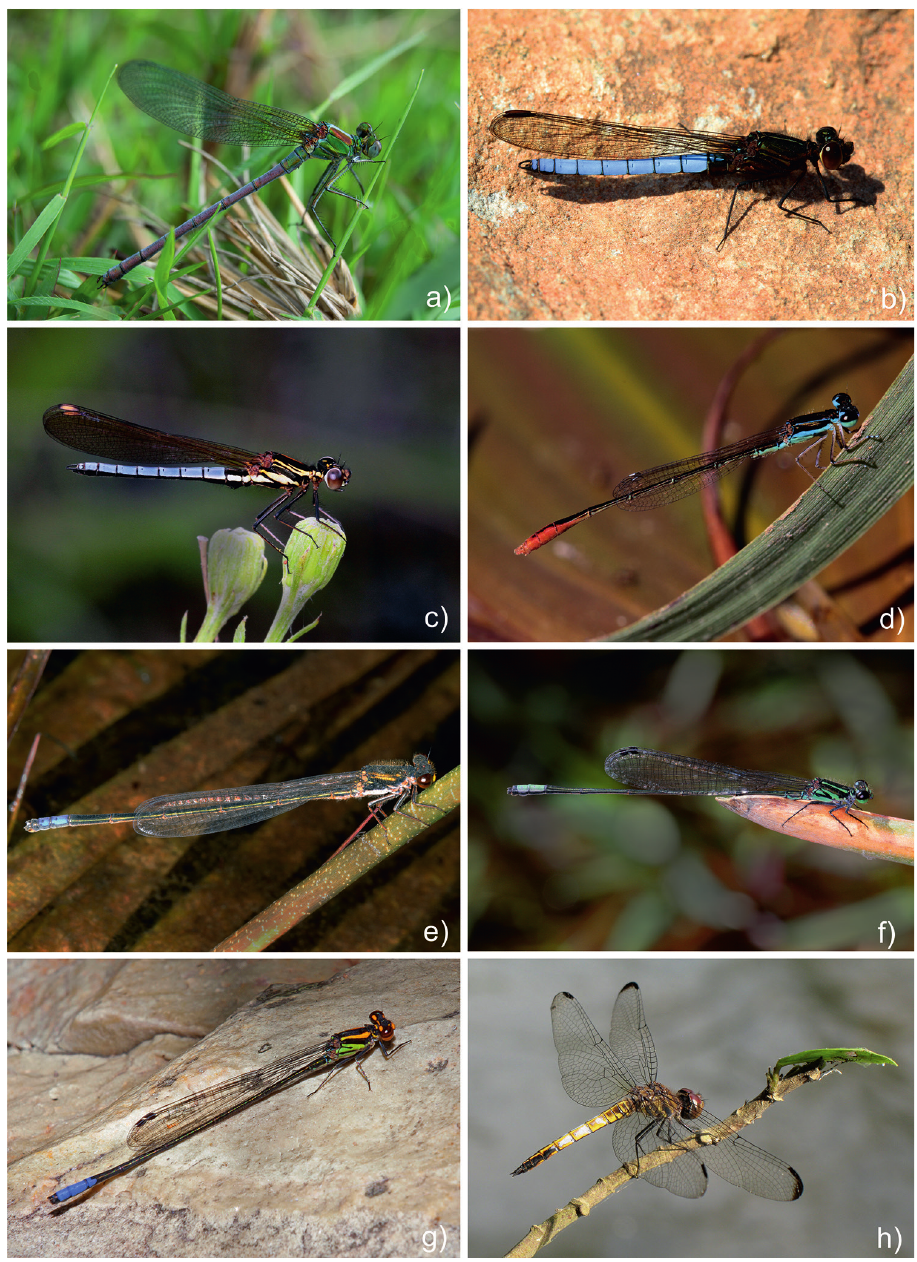
Figure 5. Photographs of some of Angola’s (near) endemic dragonflies and damselflies. a Angola Spar- klewing ( Umma femina ) b Highland Blue Jewel ( Platycypha bamptoni ) c Angola Blue Jewel ( Platycypha crocea ) d Blue Wisp ( Agriocnemis angolensis ) e Sarep Sprite ( Pseudagrion sarepi ) f Estes’s Sprite ( Pseudagri- on estesi ) g Angola Sprite ( Pseudagrion angolense ) h Sunrise Firebelly ( Eleuthemis eogaster ) ( a S. Fernandes Elizalde b–f J. Kipping g W. Tarboton, h K.D.